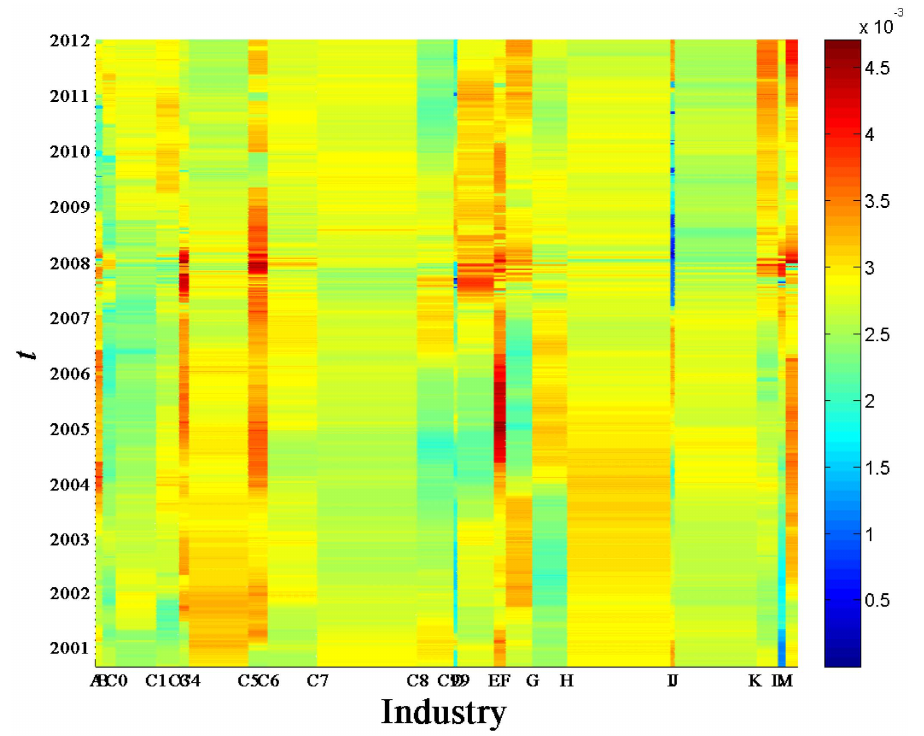
for u 1 obtained from the correlation matrix of the return series of 367 A-Share stocks Figure 8. Contribution X k of conventional industries. X k l l evolved with time t . moving window. Figure 2 plots S c ij T as a function of the evolving (PDF) of the eigenvalues and its variation over time t . In Figure 3, the PDF P ( l ) for l ƒ 20 evolved with t is plotted. The peaks of P ( l ) show larger values for t around 2003 and 2009 than those for other t . The P ( l ) for large eigenvalues l w 20 is plotted in Figure 4.